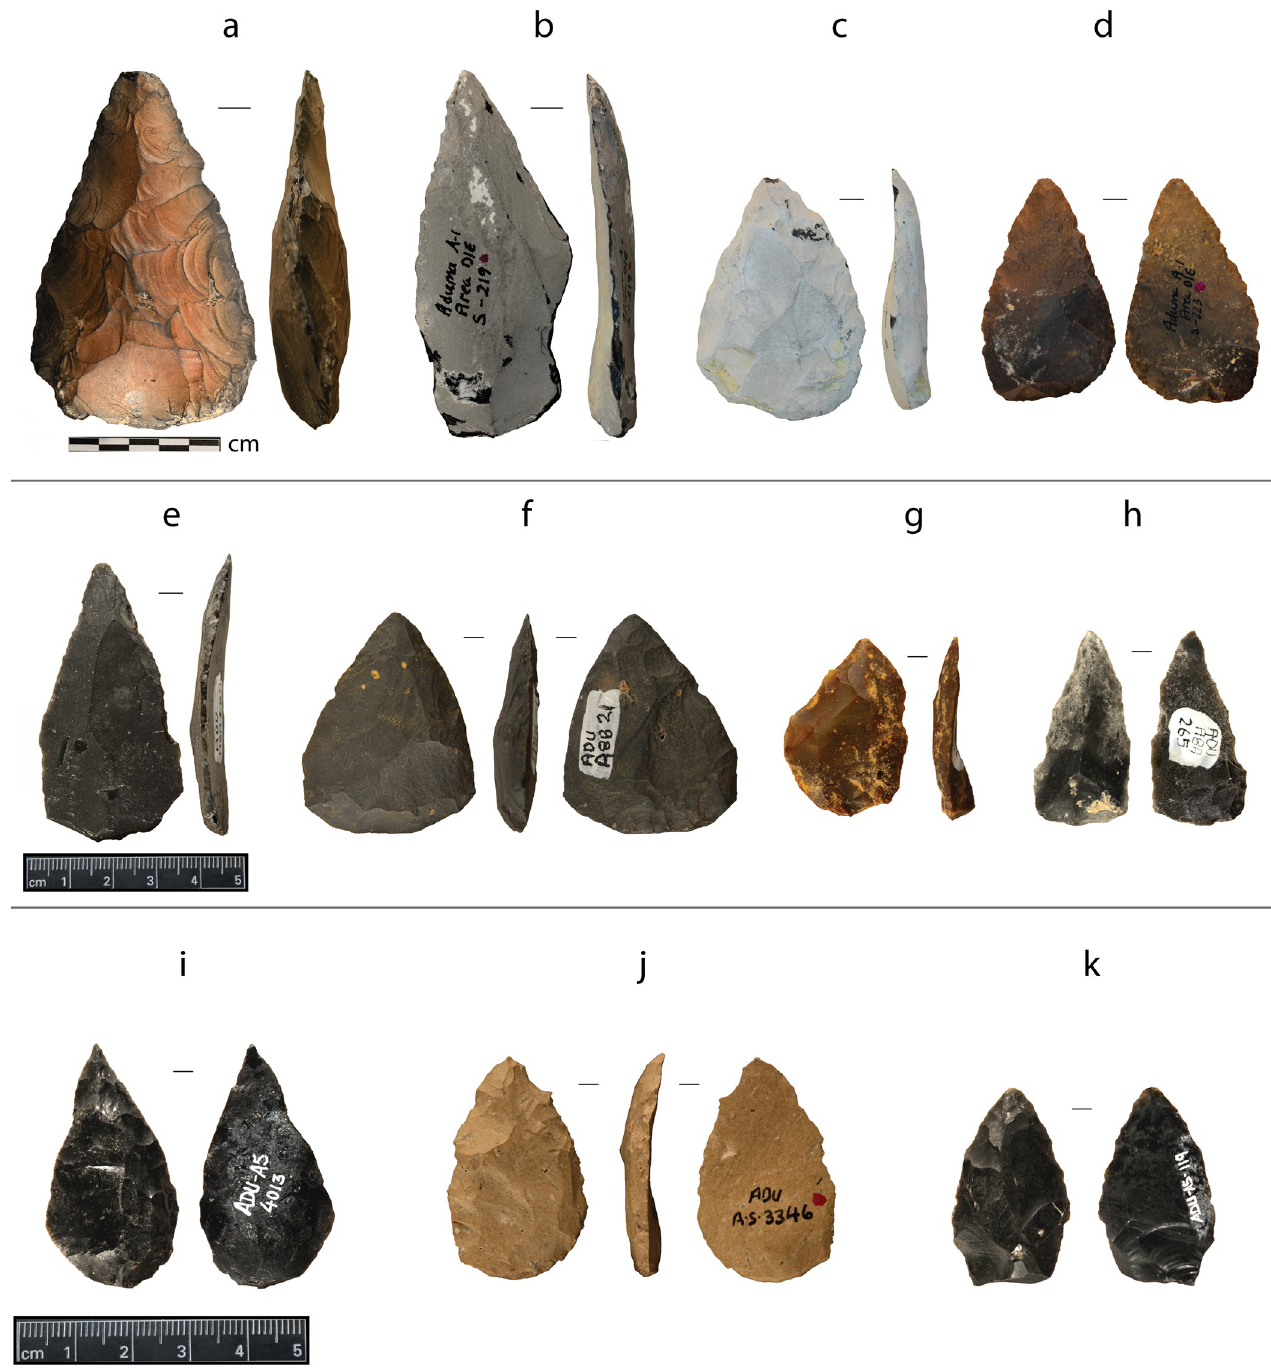
Fig 2. A sample of pointed artifacts from Aduma: A1 diminutive handaxe and points (top row); A4 and A8 points considered intermediate in age (middle row); and A5 points (bottom row). ( a ) small, triangular handaxe on obsidian; ( b-k ) points. Note that items b , e , h , and i have acute-tip; c and f broad- base; d , e , f , h , i , and k proximal retouch; and a , b , c , and h heavy